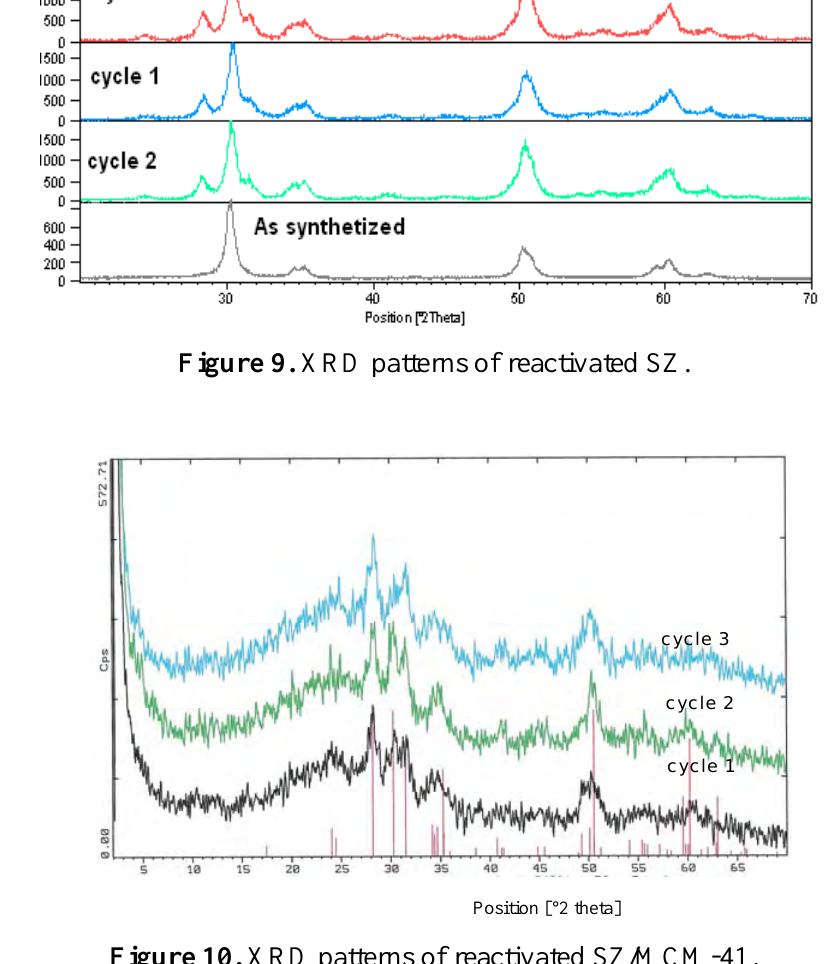
Figure 10. XRD patterns of reactivated